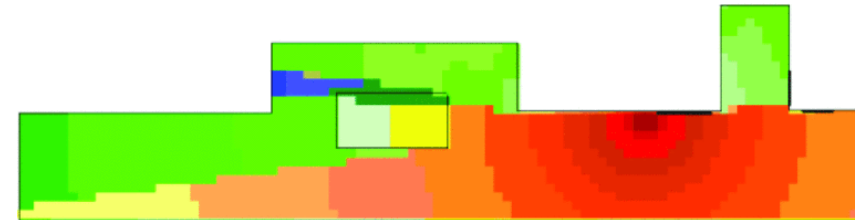
Figure 4. RFID signal propagation for antenna 1 in the corridor, taken from [11].